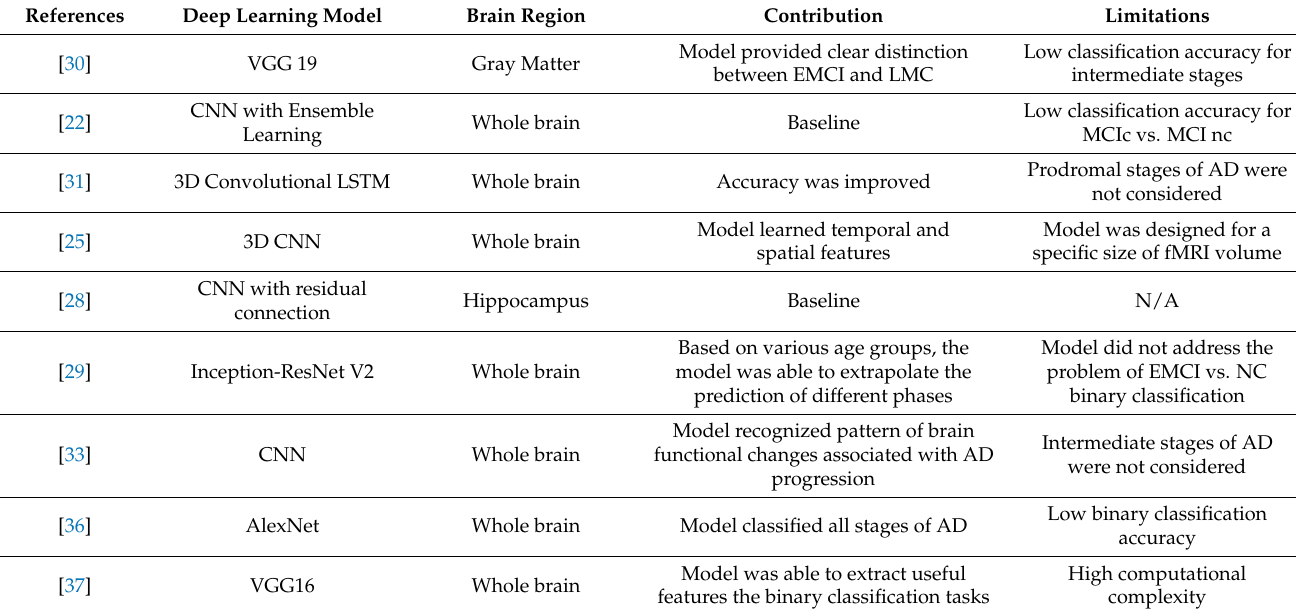
Table 1. Summary of Related